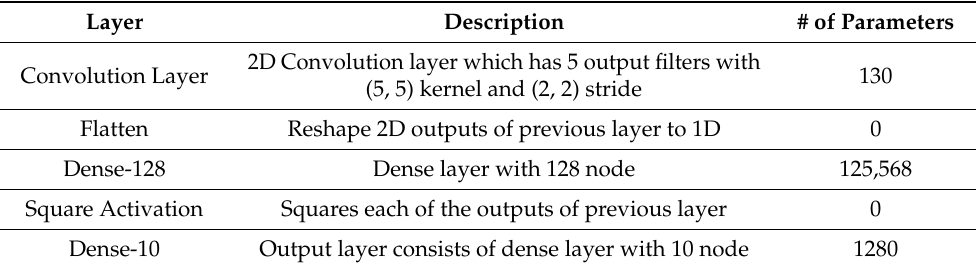
Table 2. Target model architecture for Fashion-MNIST dataset.